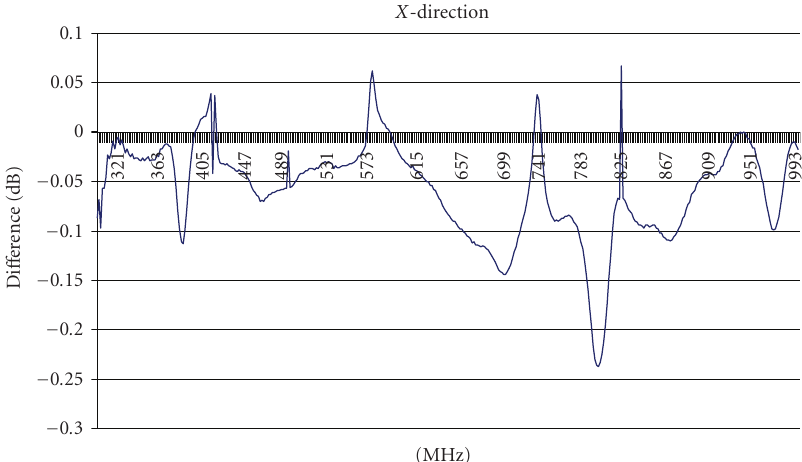
Figure 2: The di ff erence in the transmission of the GTEM cell with and without loading in the screen printed resistive lines.